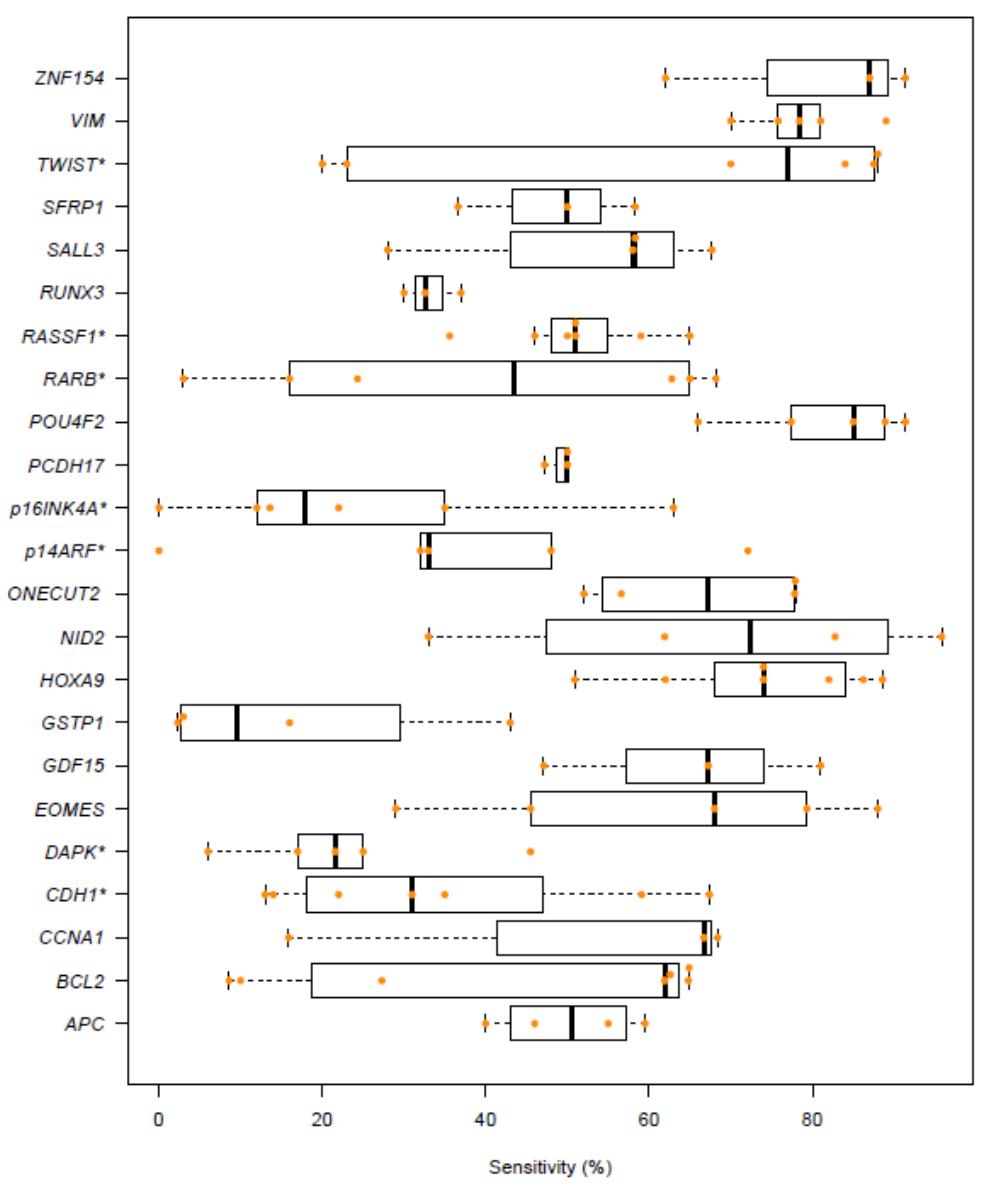
Figure 1. Reported sensitivities of DNA methylation biomarkers for detection of primary bladder cancer. *, Inconsistent nomenclature among studies.